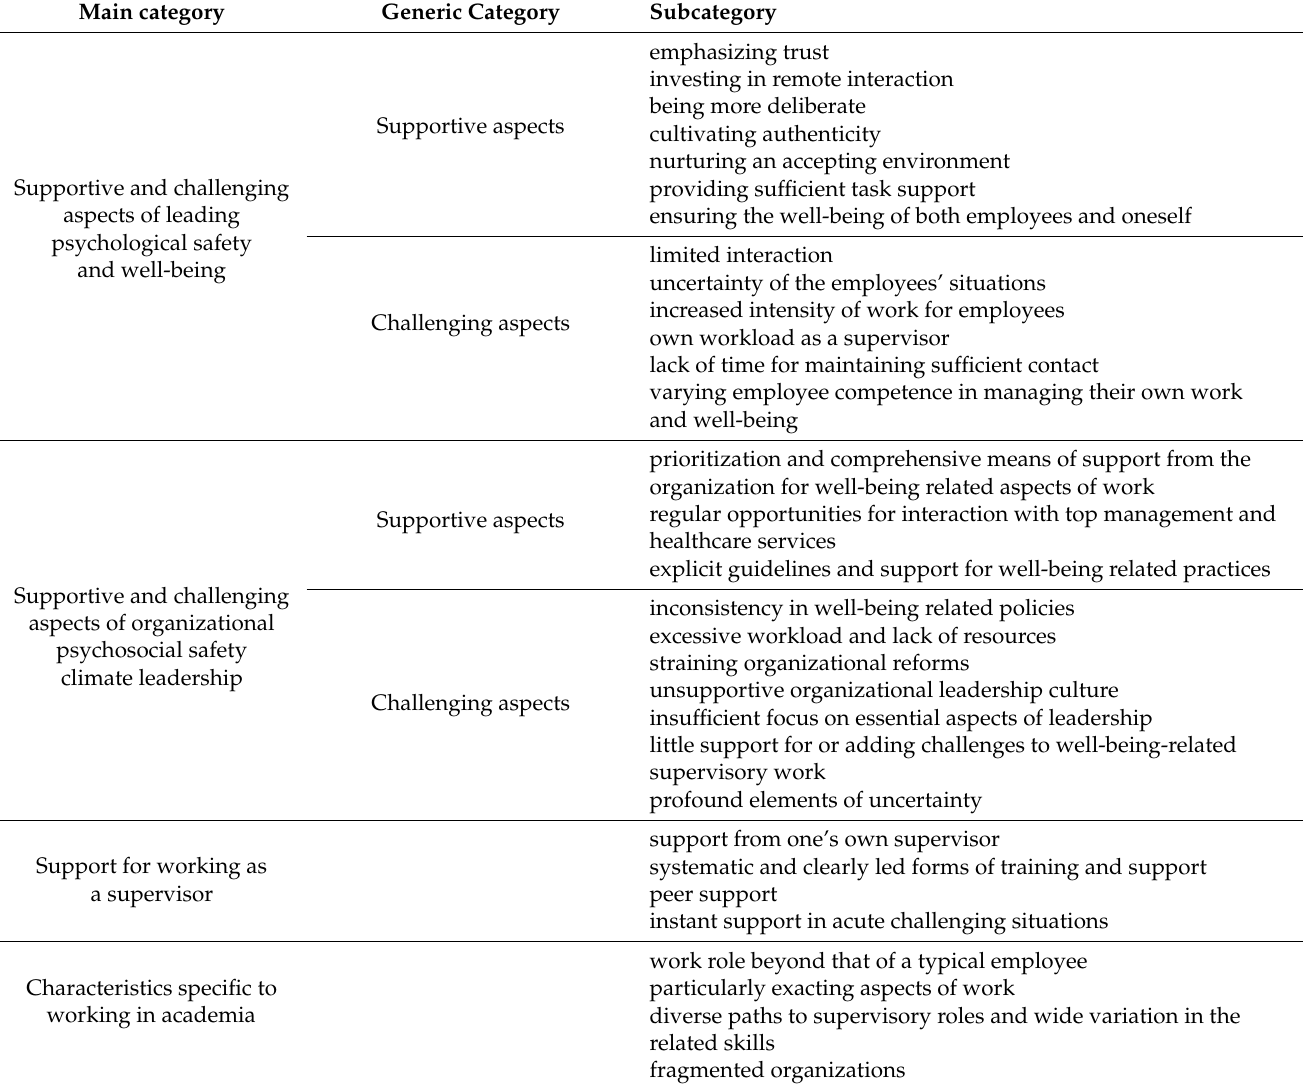
Table 1. Aspects relevant for leading psychological safety, psychological safety climate and well-being in enforced remote work in